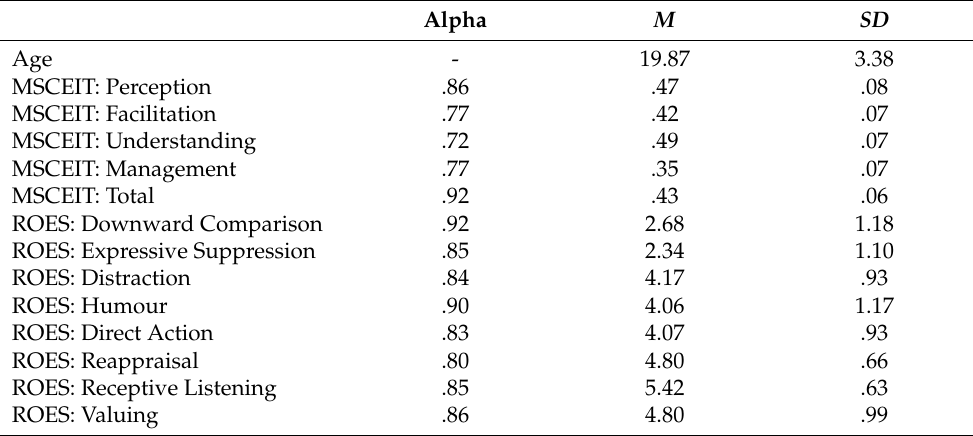
Table 1. Descriptive statistics, reliabilities, and standard deviations for study variables.